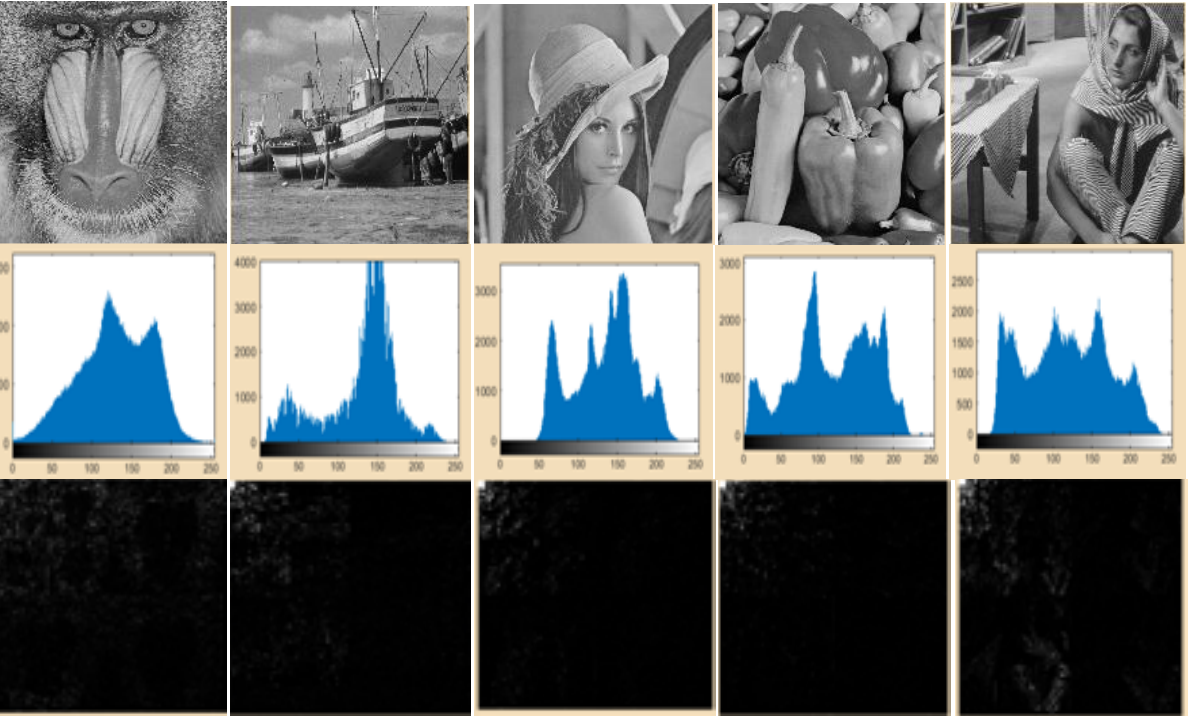
Figure 6. Row 1 original images Baboon, Boat, Lina, Pepper, Barbara (Curtsey SIPI data base), Row 2 Histograms of corresponding original Images, Row 3 Corresponding compressed image using biorthogonal